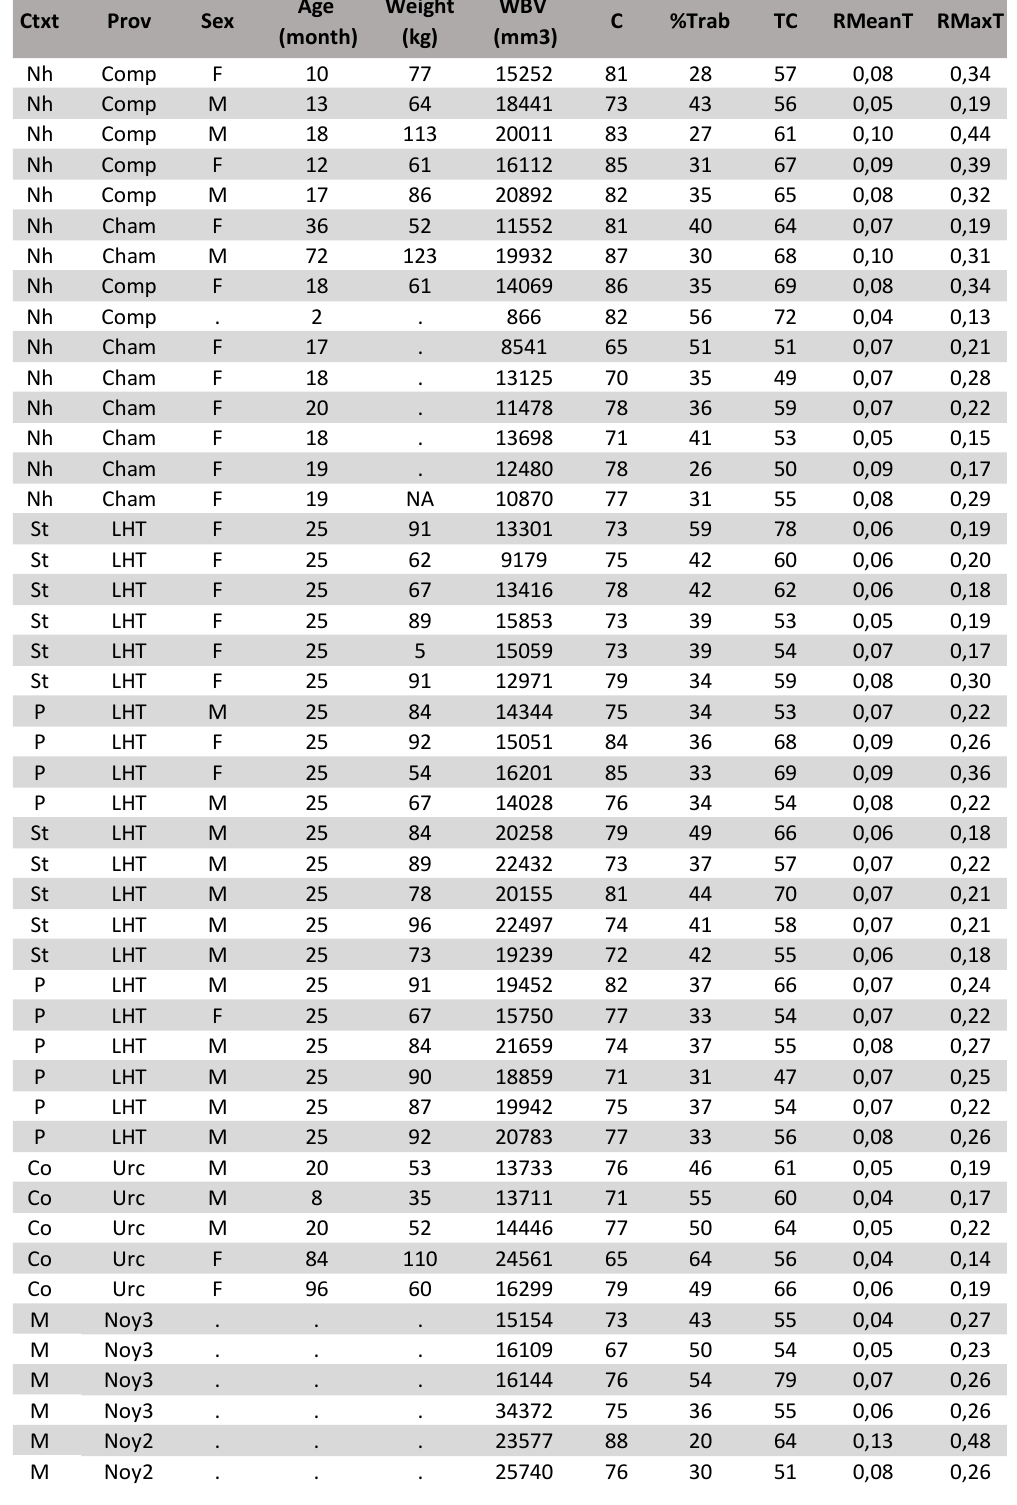
Table 1: List of material and different parameters used in this study where each row corresponds to a specimen. Ctxt, Context; Prov, Provenance; WBV, total bone volume mm3; C, compactness ratio; %Trab, percentage of trabecular bone volume to cortical bone volume; TC, trabecular compactness; RMeanT, mean relative cortex thickness; RMaxT, maximum relative cortex thickness. Nh, Natural habitat; St, Experimental stall; Co, Experimental control; M, Mesolithic; P, Experimental pen; Comp, Compiègne; Cham, Chambord; Noy2/3, Noyen-sur-seine 2/3; Urc,